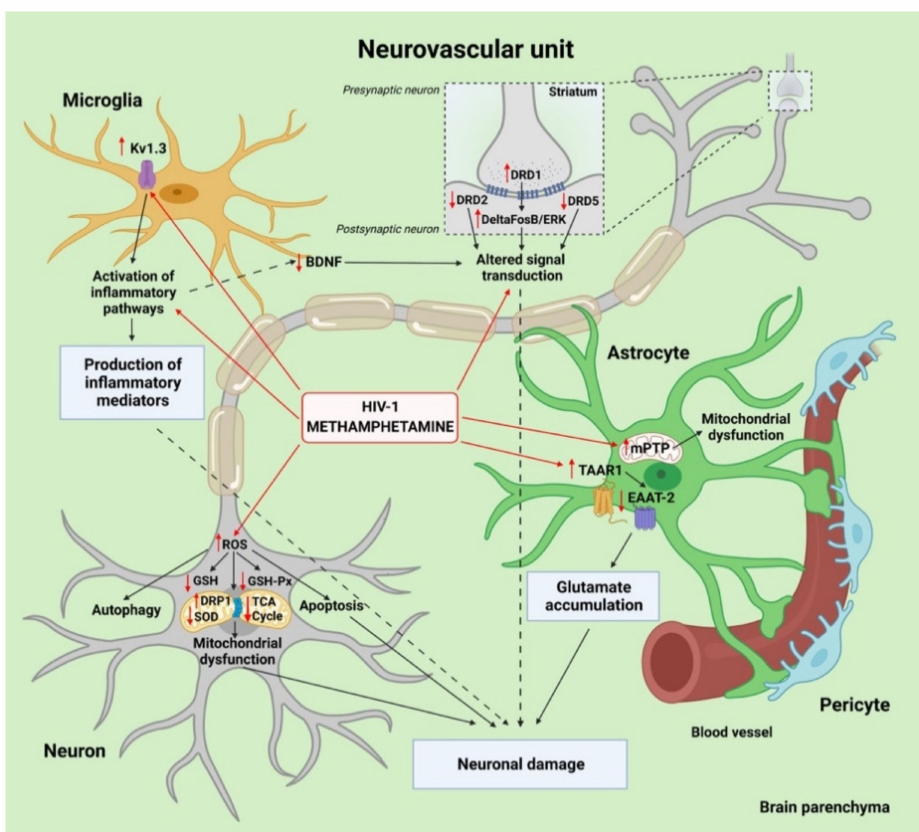
Figure 3. Synergistic cooperation between HIV-1 and methamphetamine (METH) in the neurovascu- lar unit (NVU) potentiates neuroinflammation and enhances neuronal damage. HIV-1 enters the brain via infected monocytes and CD4+ lymphocytes that cross the blood brain barrier (BBB). Once inside the brain, infected macrophages facilitate productive infection and release free virions into the brain parenchyma that infect neighboring microglia and, to some degree, astrocytes and pericytes. This infection leads to the release of neurotoxic factors and to enhanced activation of microglia. METH readily crosses the BBB due to its small size and significantly potentiates neuronal damage, mediated by microglia activation of voltage-gated potassium channel KV1.3. METH also downregulates the release of brain-derived neurotrophic factor (BDNF) from HIV-1-infected microglia. METH and HIV-1 cause astrocyte dysfunction by the opening of mitochondrial permeability transition pores (mPTPs) and modulating TAAR1/EAAT2 signaling pathways involved in glutamate clearance from the extracellular space. The other synergistic effects of METH and HIV-1 include mitochondrial fission mediated by dynamin-related protein 1 (DRP1) and impairment of the tricarboxylic acid (TCA) cycle in neurons. Furthermore, the combination of METH and HIV-1 induces neuronal oxidative damage by downregulating levels of glutathione (GSH), antioxidant defense enzymes glutathione peroxidase (GSH-PX), and superoxide dismutase (SOD). Created with BioRender.com. Recent studies have demonstrated that chronic exposure to METH exacerbates Tat- induced neurotoxicity, partially due to causing excessive ROS production and impairing antioxidant systems [115]. For example, a study based on human SH-SY5Y